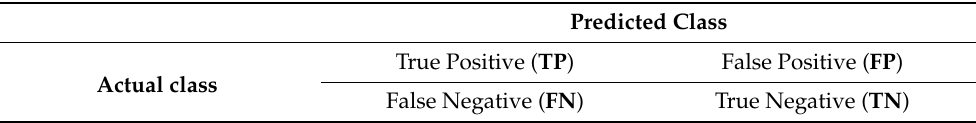
Table 2. Confusion